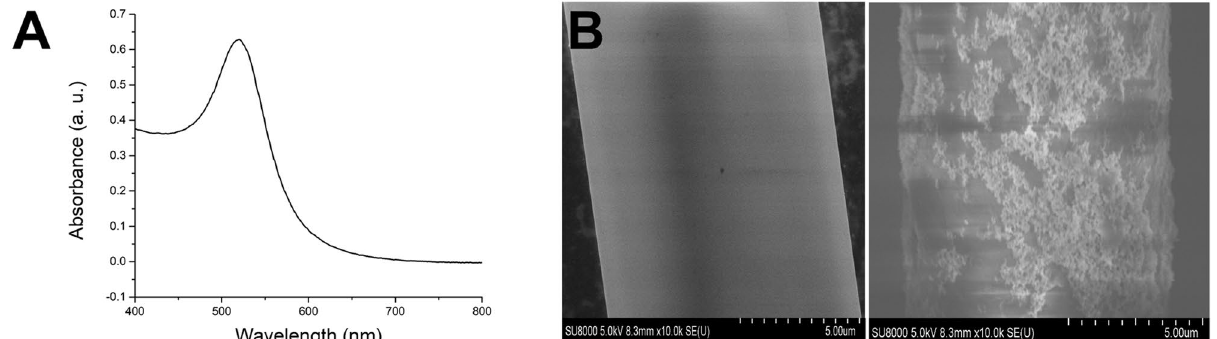
Figure 2. ( A ) UV–Vis spectra of the synthesized gold nanoparticles (AuNPs). ( B ) Scanning electron microscopy (SEM) of bare and AuNPs-decorated TOF.